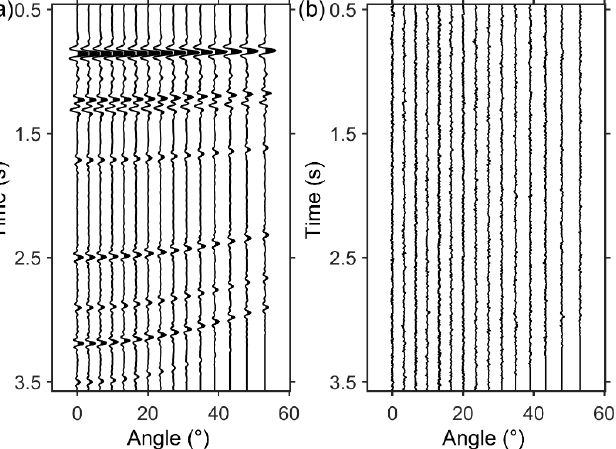
Figure 15. Comparison between the true model at 2.25 km and the inverted model from the noisy data using the wave-equation-based inversion method: ( a ) P-wave velocity, ( b ) S-wave velocity, and ( c ) density. The black arrow indicates the location of the gas hydrate reservoir.